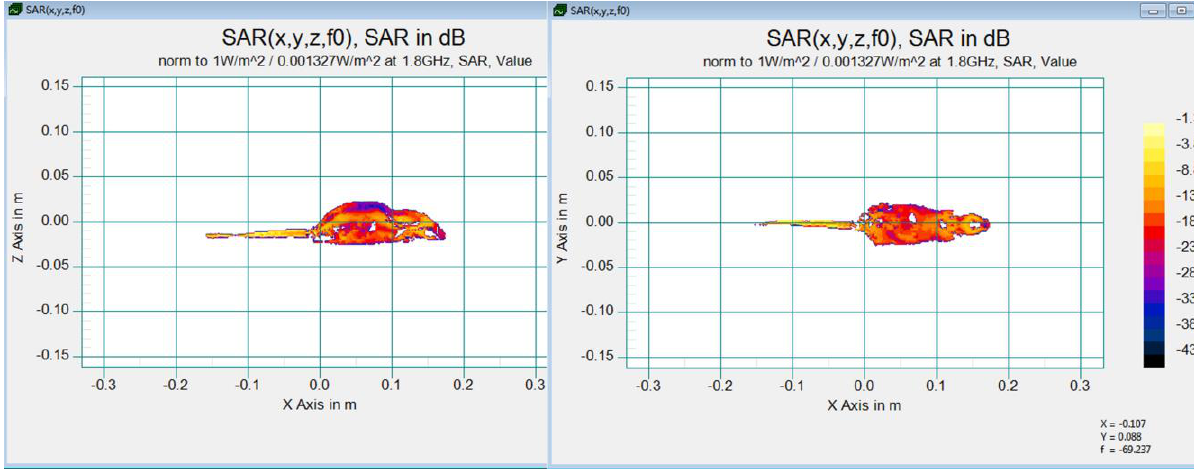
Figure 2. SAR distribution in a phantom 198 g male rat, front and top